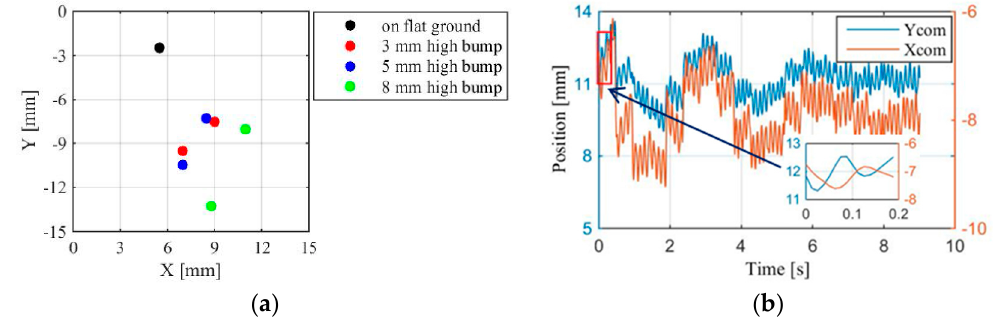
Figure 12. Results of experiment on the foot system. ( a ) The stable values of CoM projections under different experimental conditions; and ( b ) the CoM positions in the X and Y axis versus time.